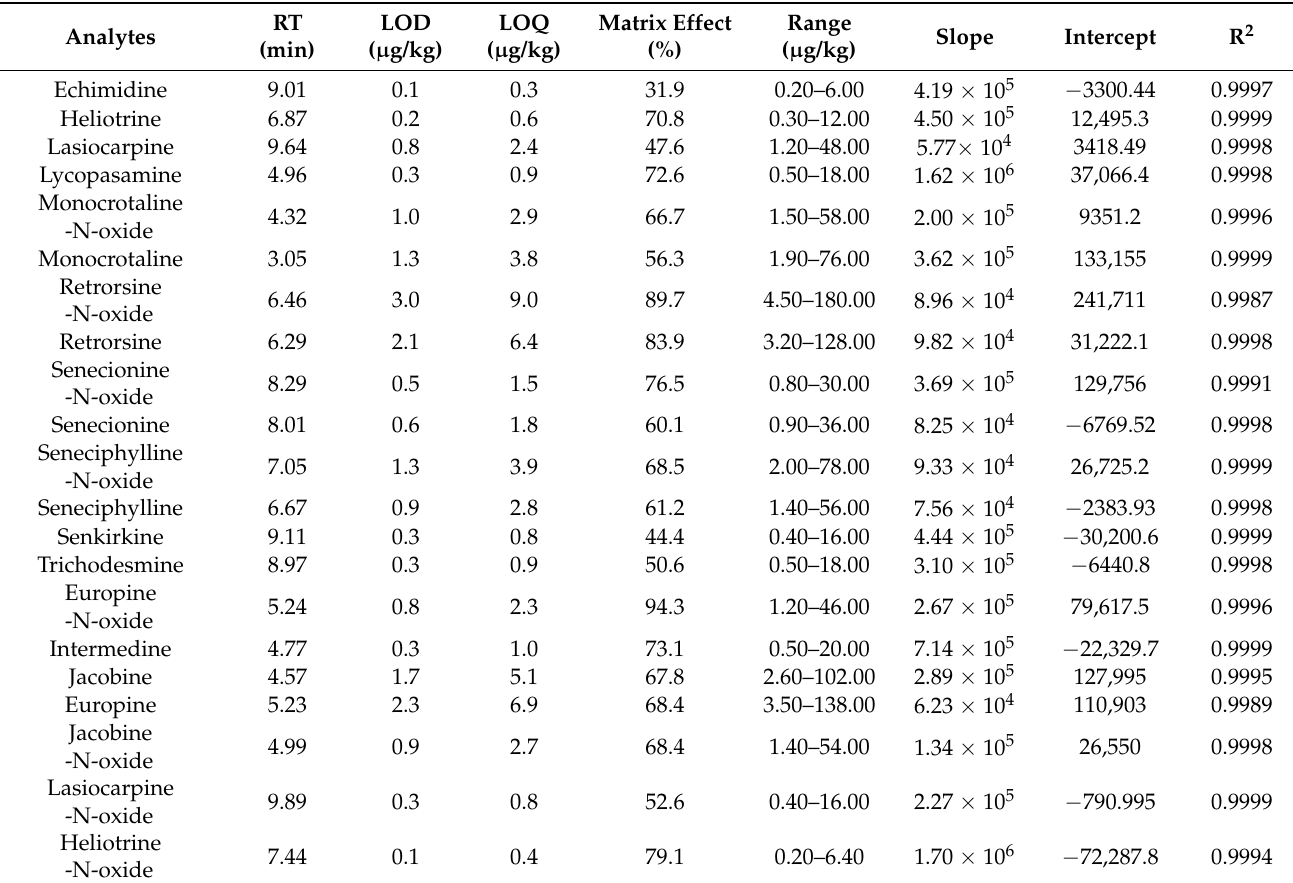
Table 2. LOD, LOQ, matrix effects, and calibration curves of the PAs in tea